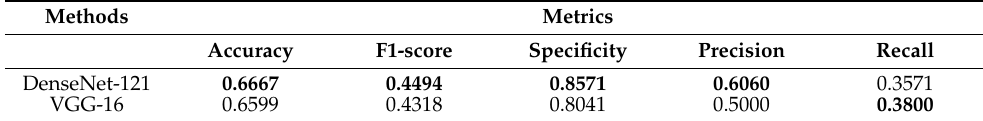
Table 5. Performance of the pretrained networks DenseNet-121 and VGG-16 considering the test sets for the classification scenario of 730 images (without lesions and with lesions between 0.5 and 1.9 mm) from the UFPE database. The best values are presented in